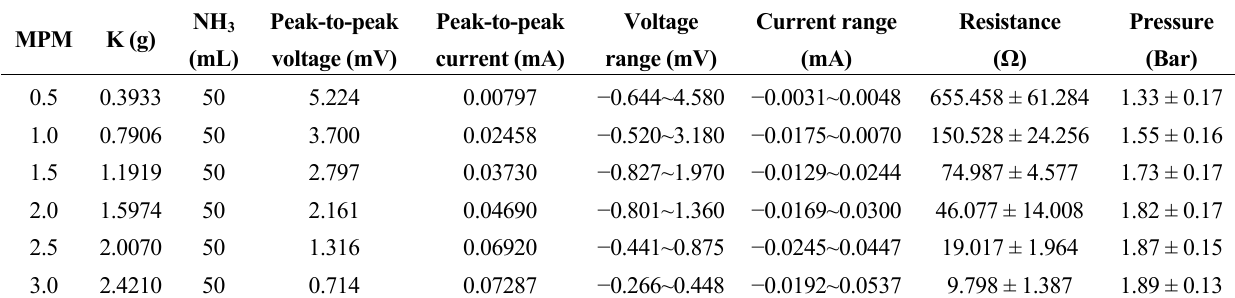
Table 2. Related data of Figures 4 and 5.